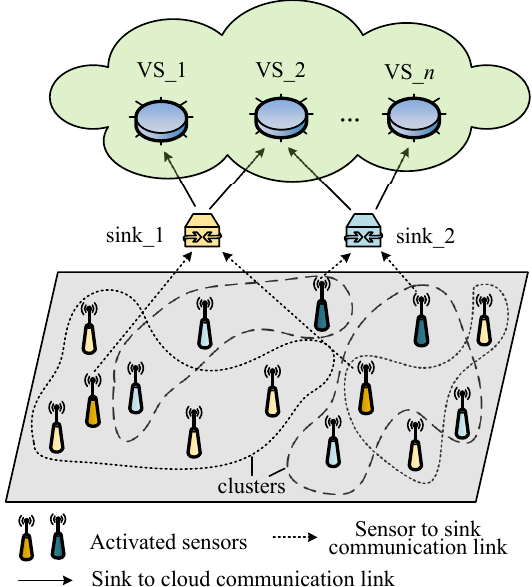
Figure 2. Virtualization of the physical